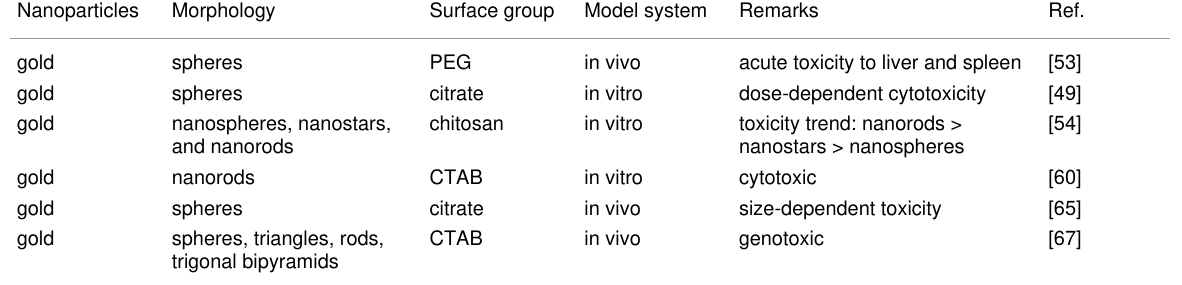
Table 1: In vitro and in vivo toxicity studies of gold nanoparticles of different shapes with different surface groups. Nanoparticles